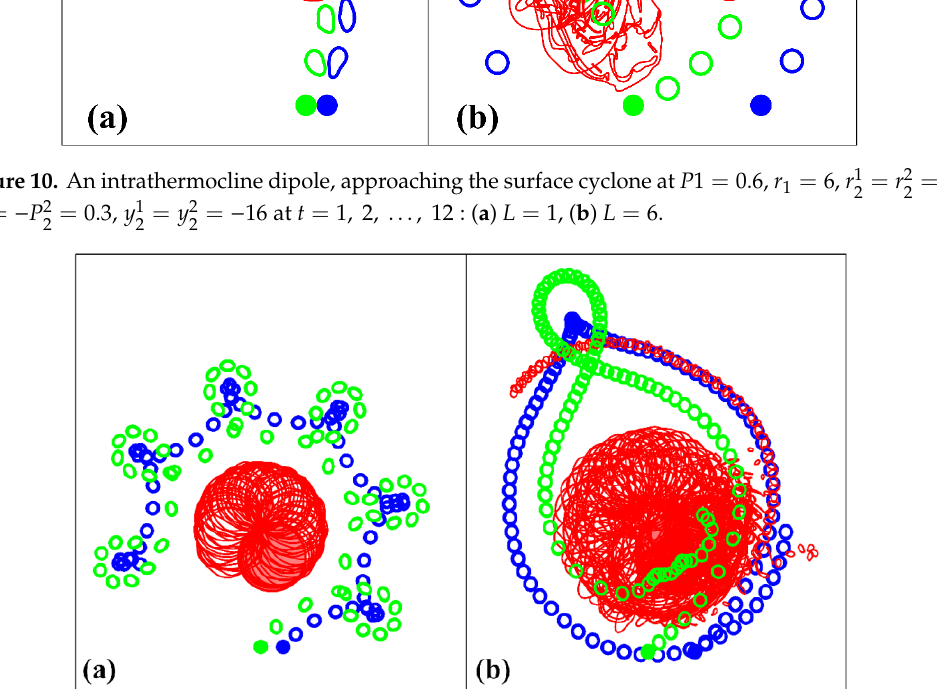
Figure 11. Sets of superimposed vortex patches contour at r 1 =6, 𝑟 21 = 𝑟 22 = 1, 𝛲 21 𝛲 22 ⁄ = −1 2,⁄ 𝛲 21 𝛲 11 ⁄ = 1 2,⁄ 𝑦 21 = 𝑦 22 = −16, and ( a ) 𝐿 = 2, ( b ) 𝐿 =